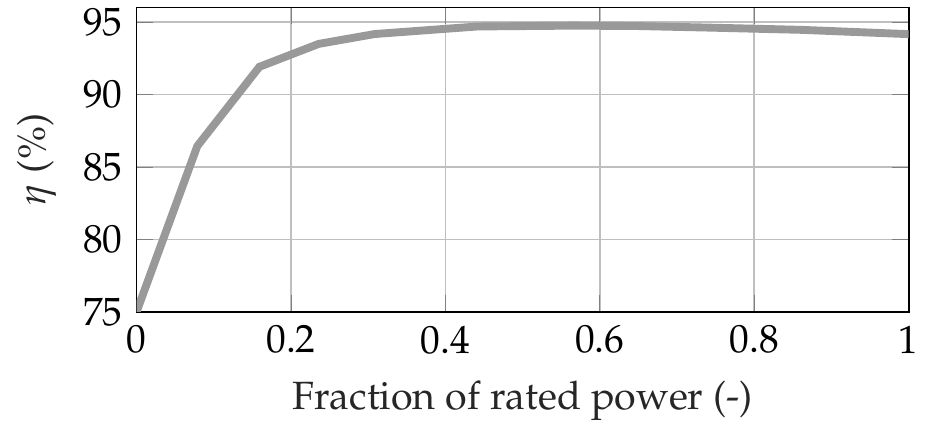
Figure 7. Efficiency map of the machine including inverter. Dashed line shows the constant power limit.